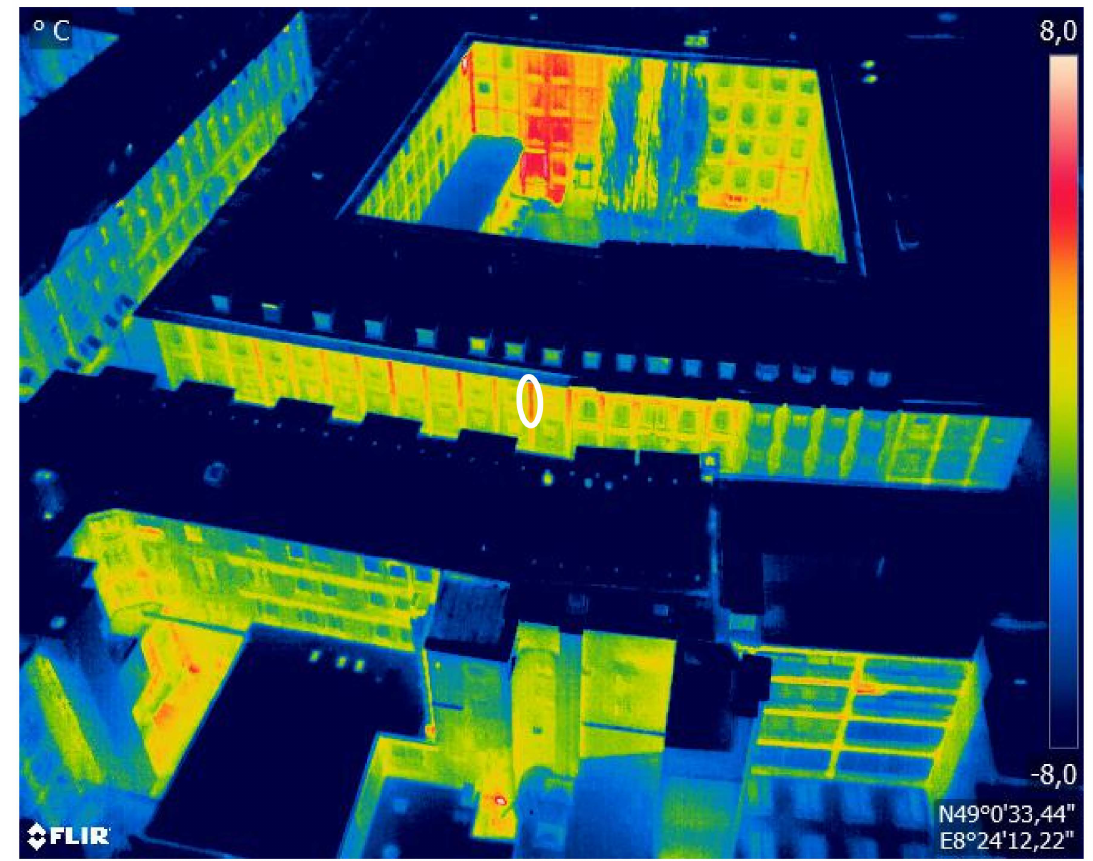
Figure A5. Example: thermal bridge of an inside wall/column.